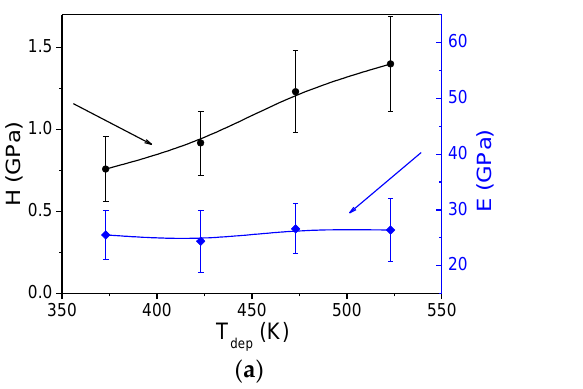
Figure 14. Temperature dependencies of ( a ) hardness, Young’s modulus, and ( b ) the elasticity index (H/E) and plasticity index (H 3 /E 2 ) of PECVD BC x N y O z films. Table 8. Mechanical properties of PECVD BC x N y O z